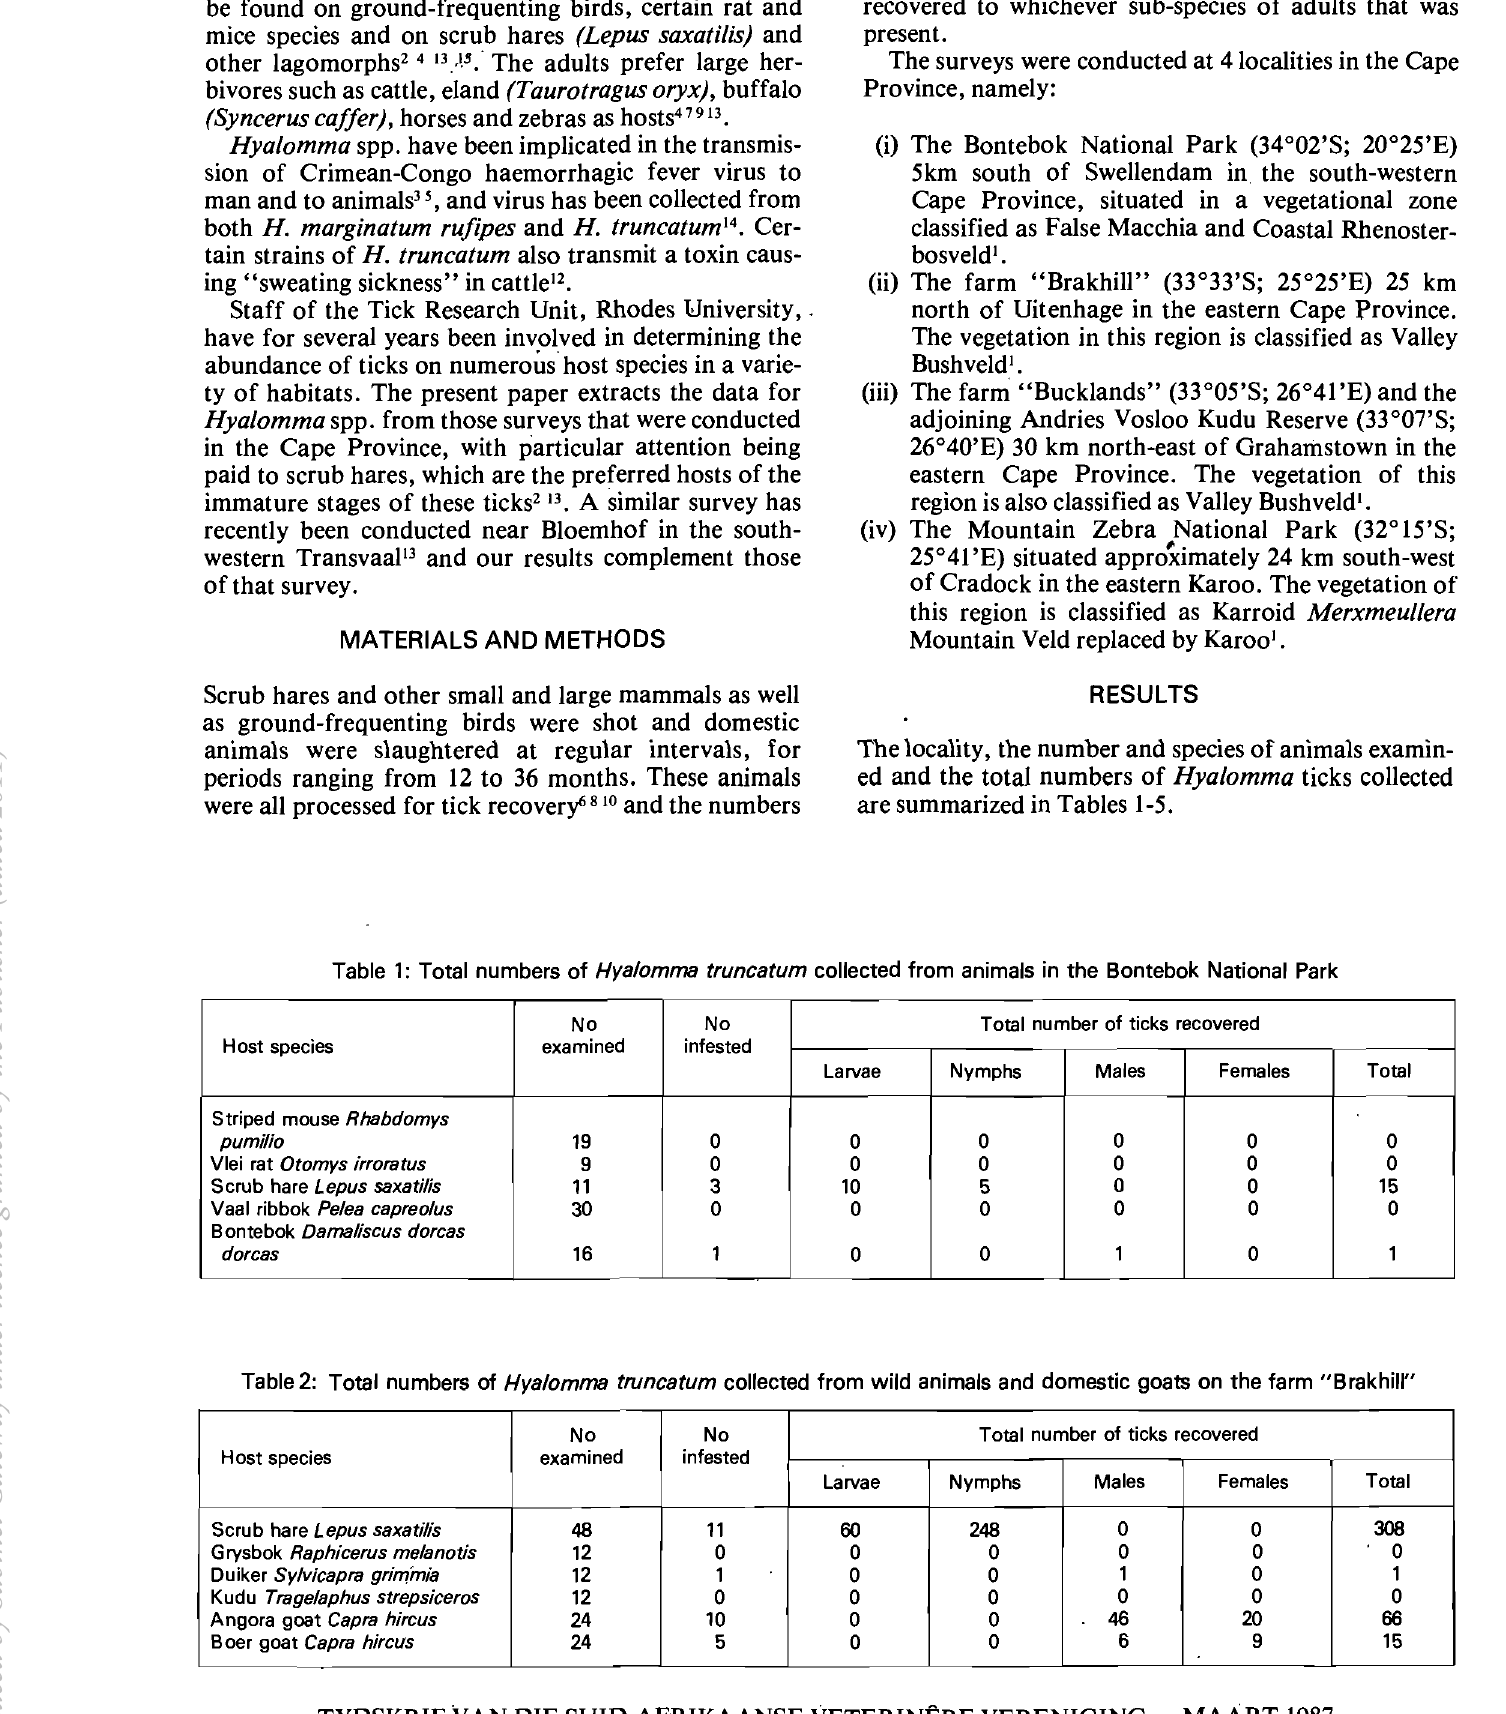
Table 2: Total numbers of Hyalomma truncatum collected from wild animals and domestic goats on the farm "Brakhill"